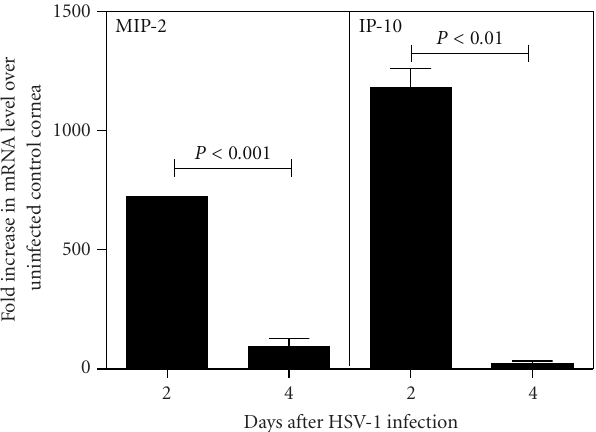
Figure 2: Expression of IP-10 mRNA is upregulated during the first 48 hours of HSV-1 infection of the cornea. Mice ( n = 3) were challenged by intrastromal injection with 1 × 10 4 PFU HSV-1 and corneas were harvested at the indicated times post infection. Con- trol mice were uninfected and corneas from this group represented the level of constitutive mRNA production for each chemokine. Total RNA was isolated from each group and converted to cDNA which was analyzed by real-time PCR. Upregulation in mRNA for each chemokine is reported as the fold increase over production in uninfected control